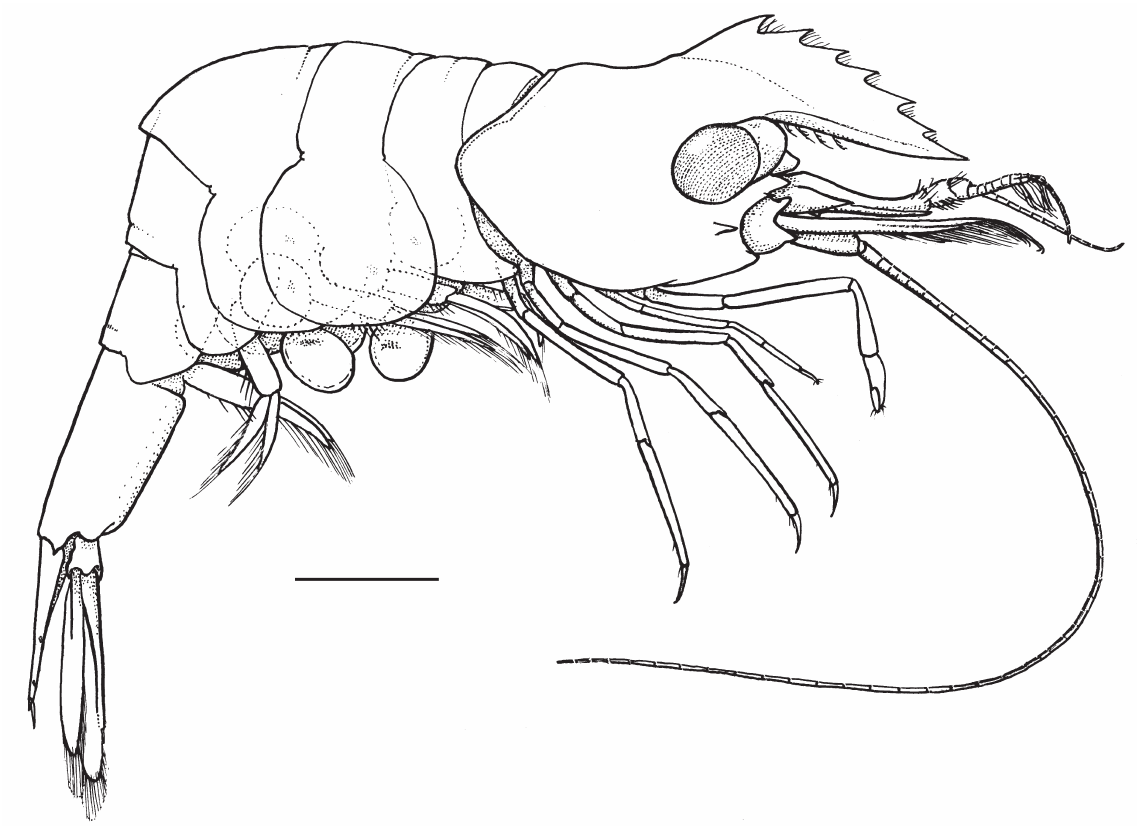
Fig. 1. Hamodactylus paraqabai sp. nov., ovigerous ♀ , holotype (PoCL 1.5 mm; Madang, Papua New Guinea ), habitus. Scale bar = 1